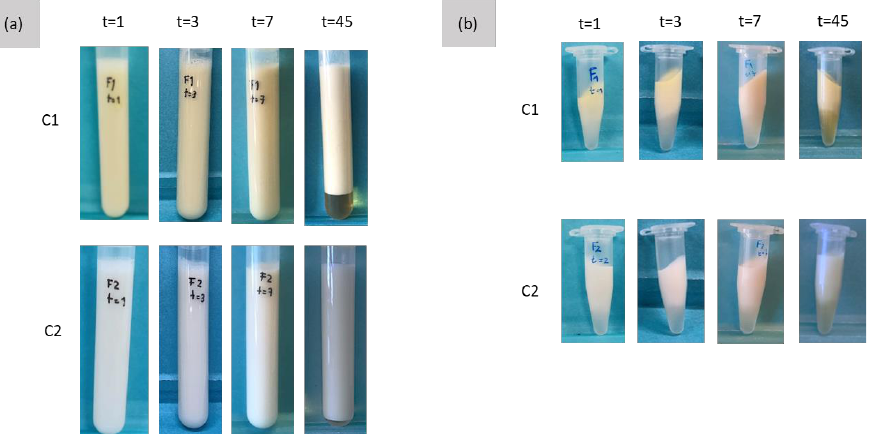
Figure 4. ( a ) Emulsification index over storage period (t = 1, 3, 7, 45 days); ( b ) centrifugation test over storage period (t = 1, 3, 7, 45 days).